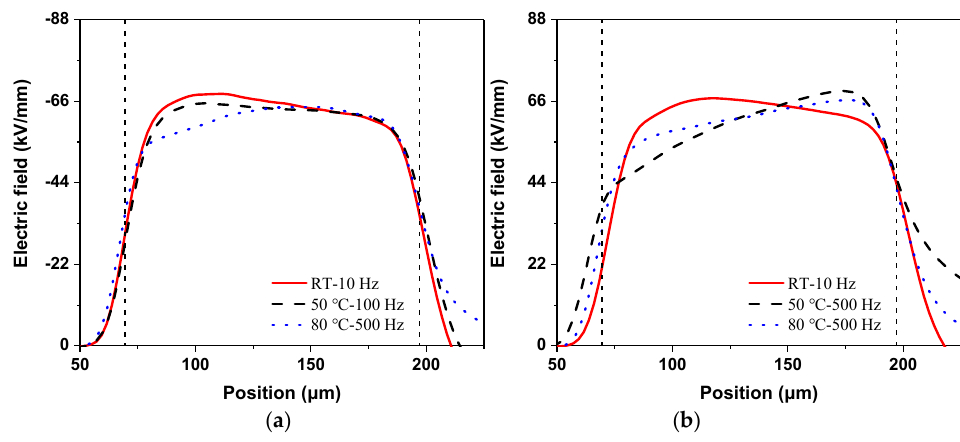
Figure 10. Electric field results under half-wave sine voltages at different temperatures: ( a ) positive voltages, ( b ) negative voltages.